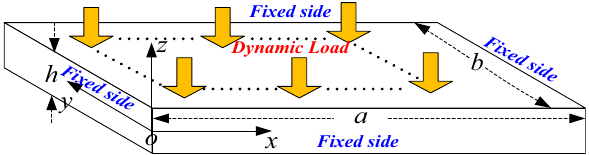
Figure 1. Mechanical calculation model of single layered thin plate rock